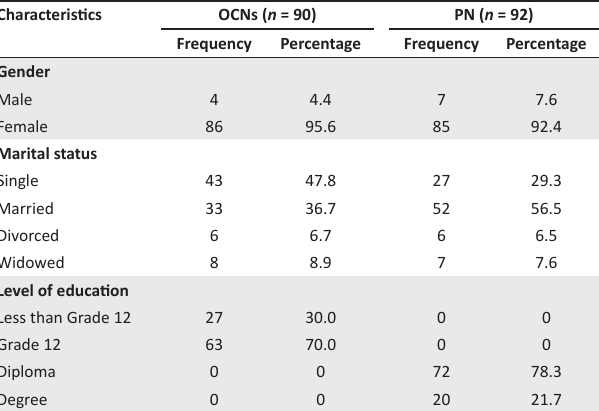
TABLE 1: Demographic and professional characteristics of the study participants ( n = 182).